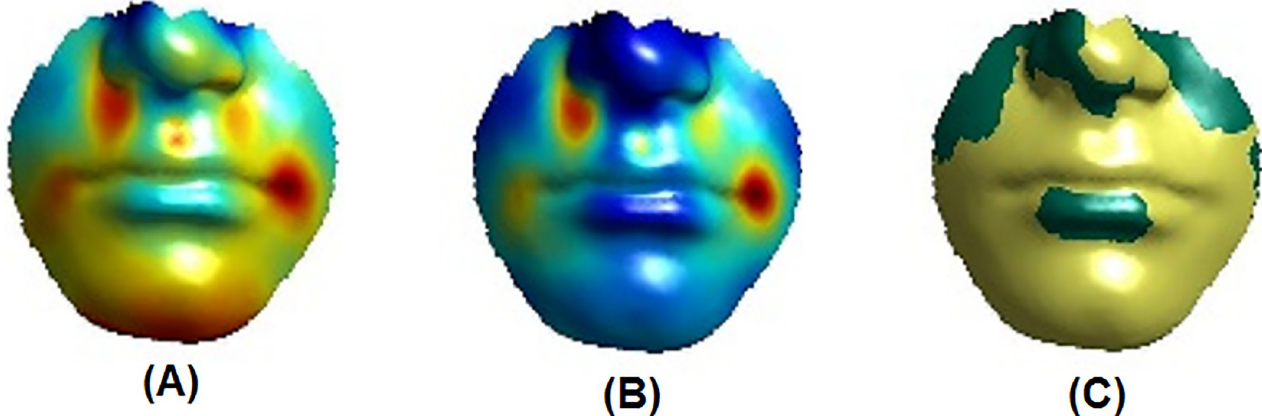
Fig 10. Regression results. Effect of a manual label (philtrum shape) on the lower face. (A) Partial coefficients. (B) R 2 . (C) p < 0.001 (yellow), p � 0.001 (green). Warmer colours correspond to stronger effects. https://doi.org/10.1371/journal.pone.0221197.g010 Experiment 6: Visualisation of the effect of trait categories on the lip region